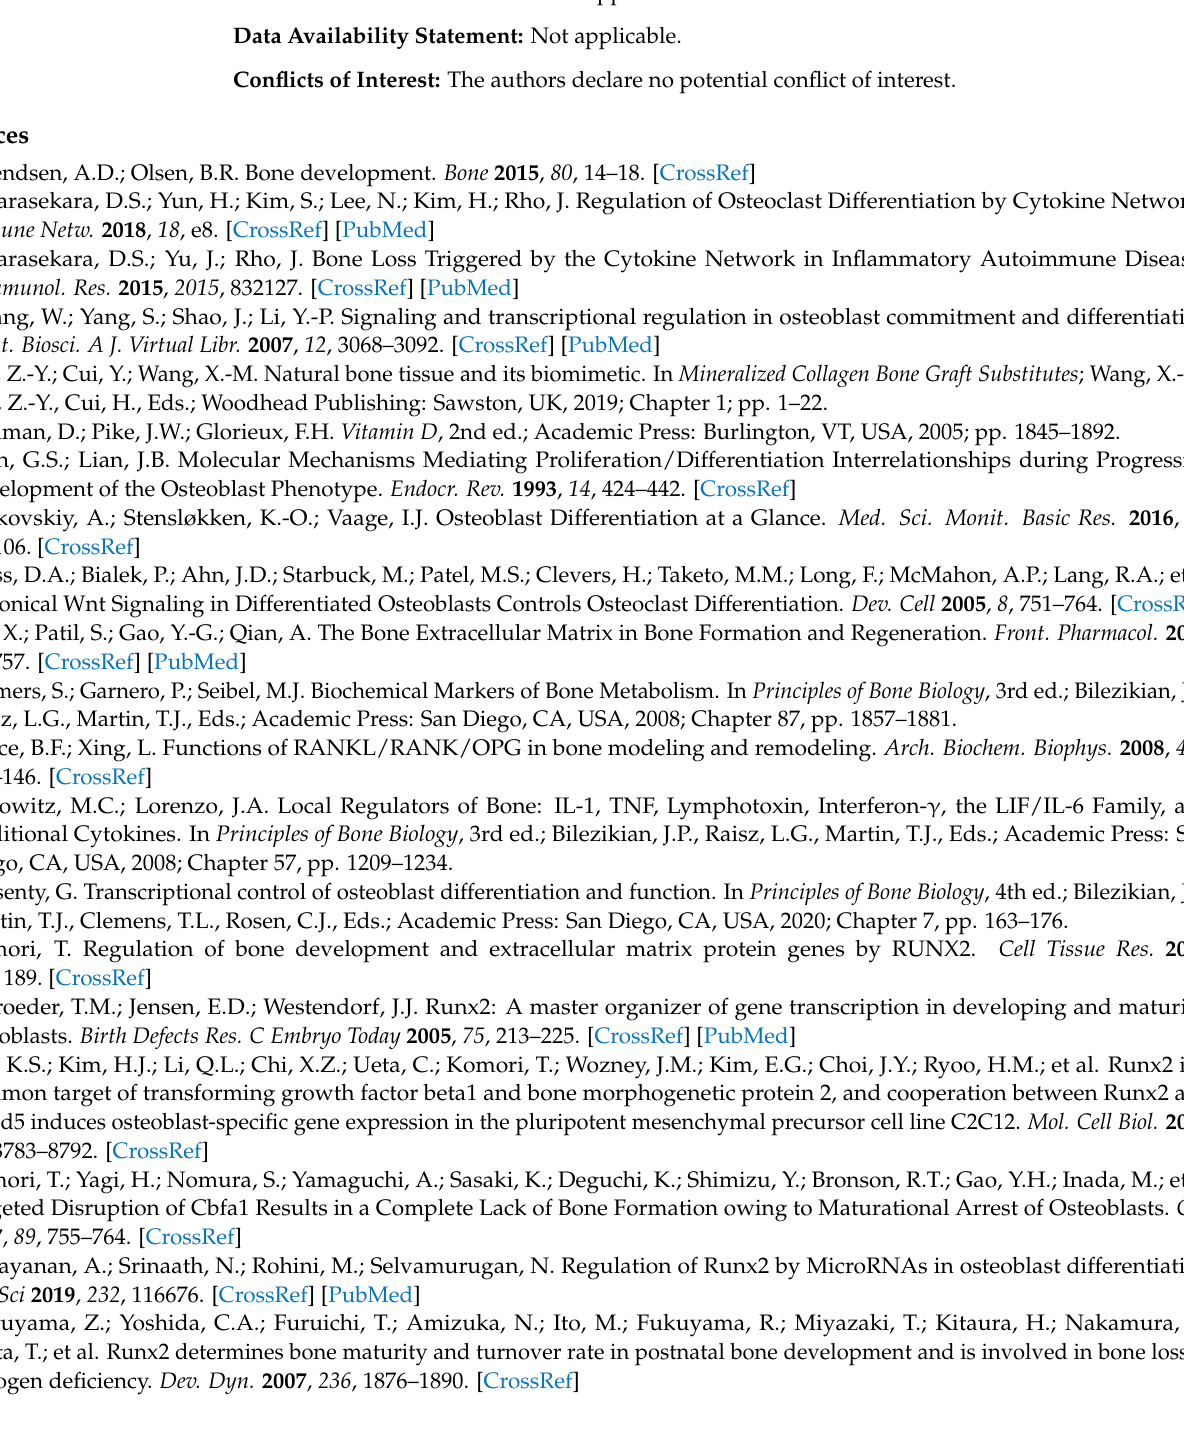
figure design; J.R. supervised the research and edited the manuscript. All authors have read and agreed to the published version of the